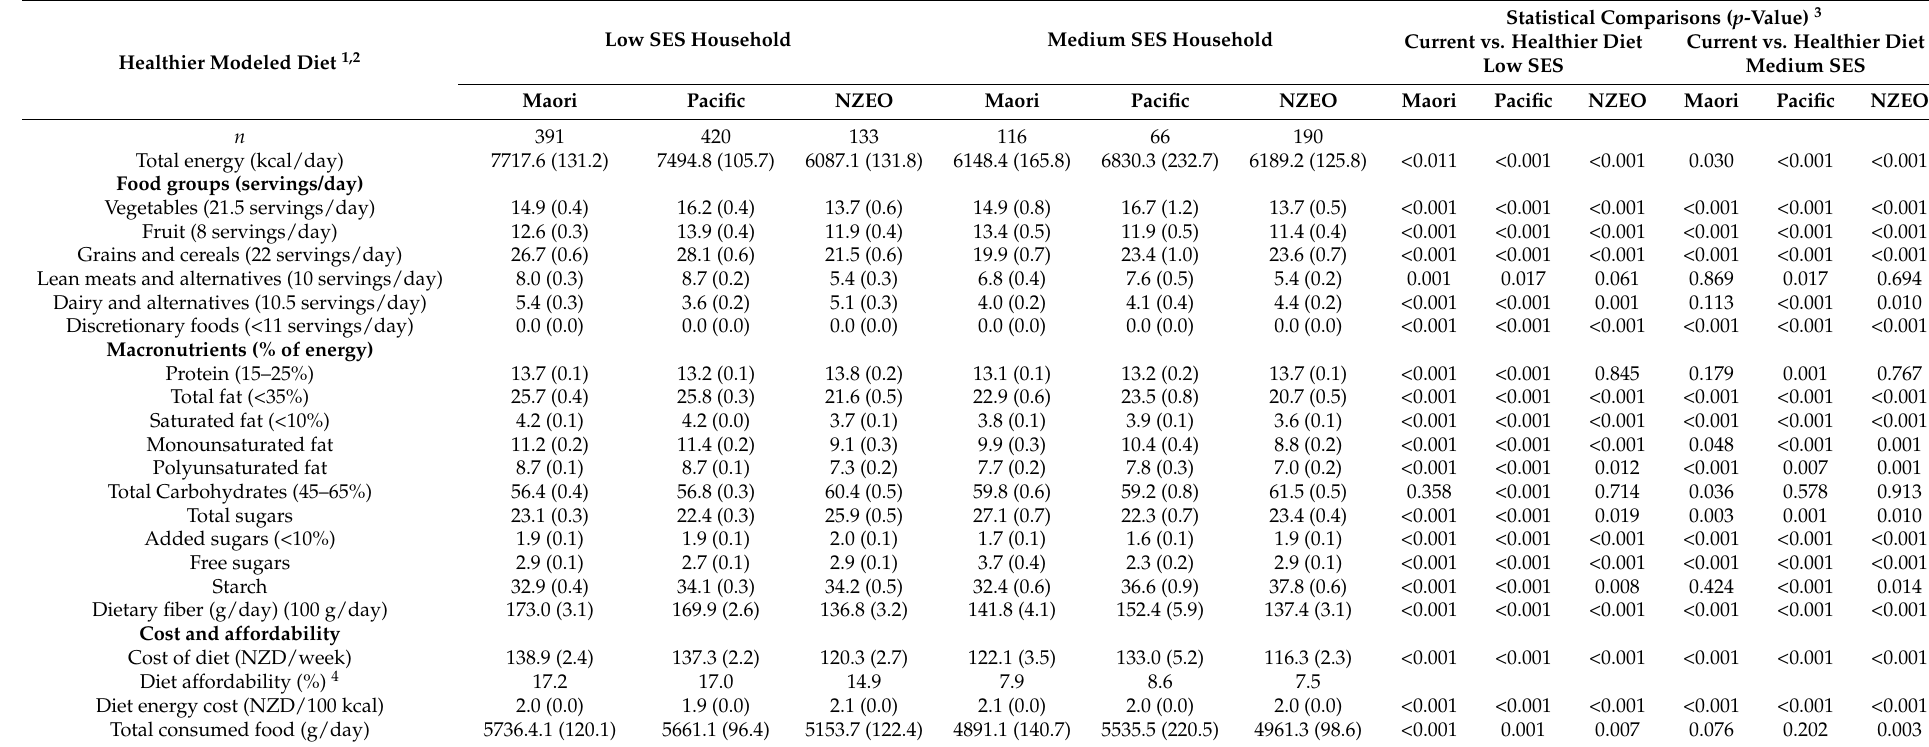
Table 4. The theoretical modeled healthier, low-cost NZ diet for each reference household, by ethnicity and